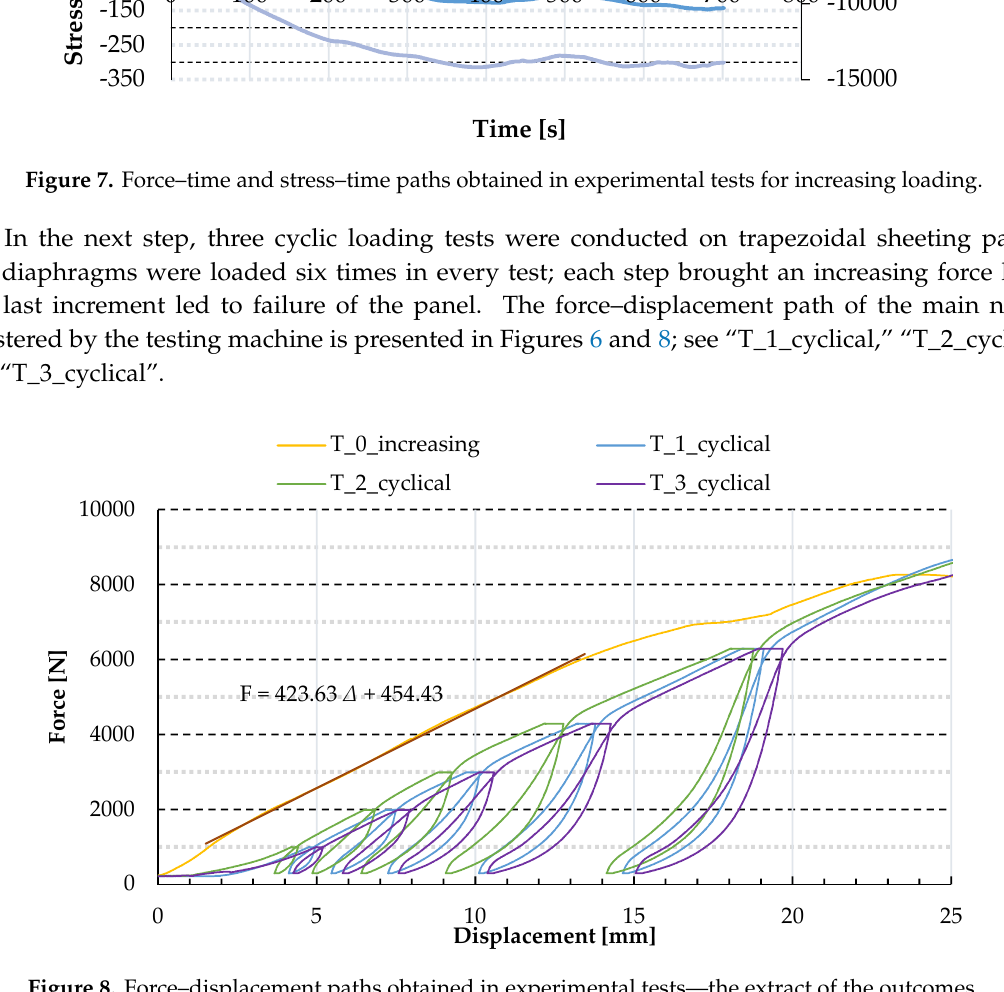
Figure 8. Force–displacement paths obtained in experimental tests—the extract of the outcomes.